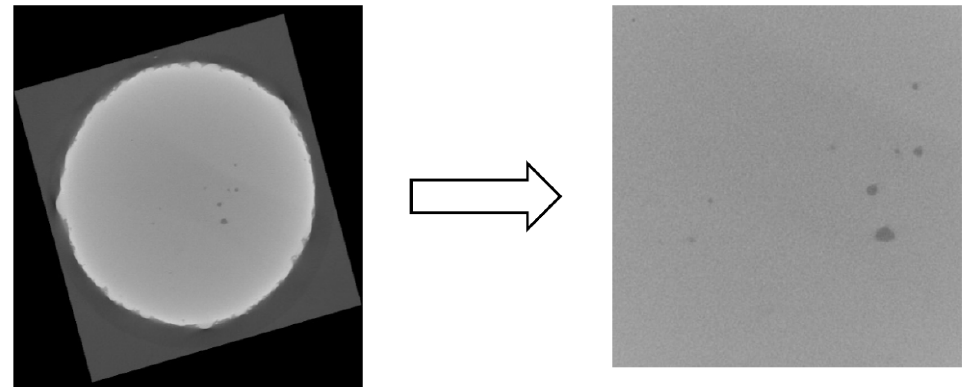
Figure 18. Illustrative example of the real existing porosity images [26]. Figure 19 presents the real image along with the first version of the artificial image.